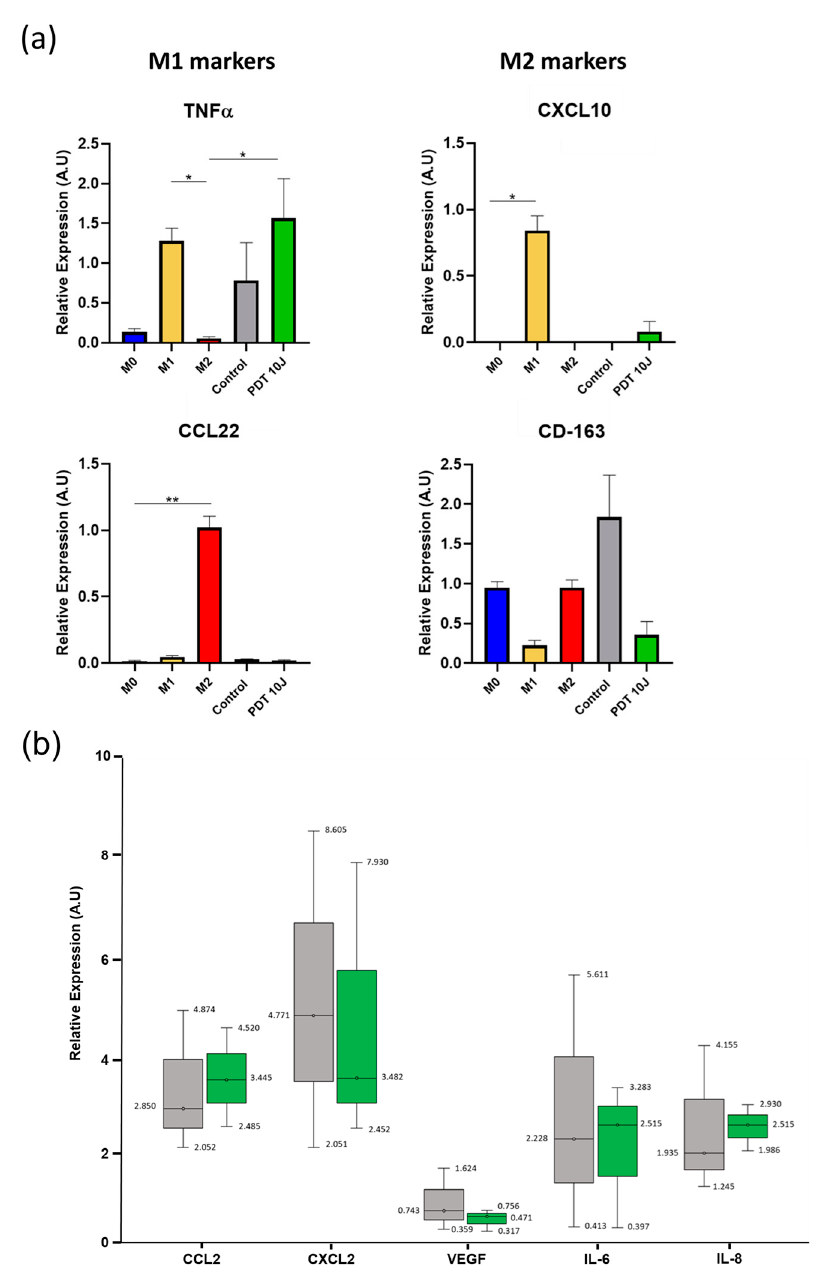
Figure 8. Effect of U87 secretome pre- and post-PDT on macrophage gene expression. ( a ) ARN extractions were performed 24 h after THP-1 polarization protocol. RT-qPCR was carried out on samples at 25 ng · µ L − 1 using SYBR Green as a fluorescent reporter for quantification. The mean relative gene expression of the markers for M1 and M2 ( n = 3, mean + SD, * p < 0.01; ** p < 0.001 by Kruskal–Wallis test). ( b ) Secretome analysis by Proteome Array, pre- (in grey) and post-PDT (in green) ( n = 3). We analyzed several cytokines, including CCL2, CXCL2 (macrophage recruitment), VEGF, IL-6, and IL-8